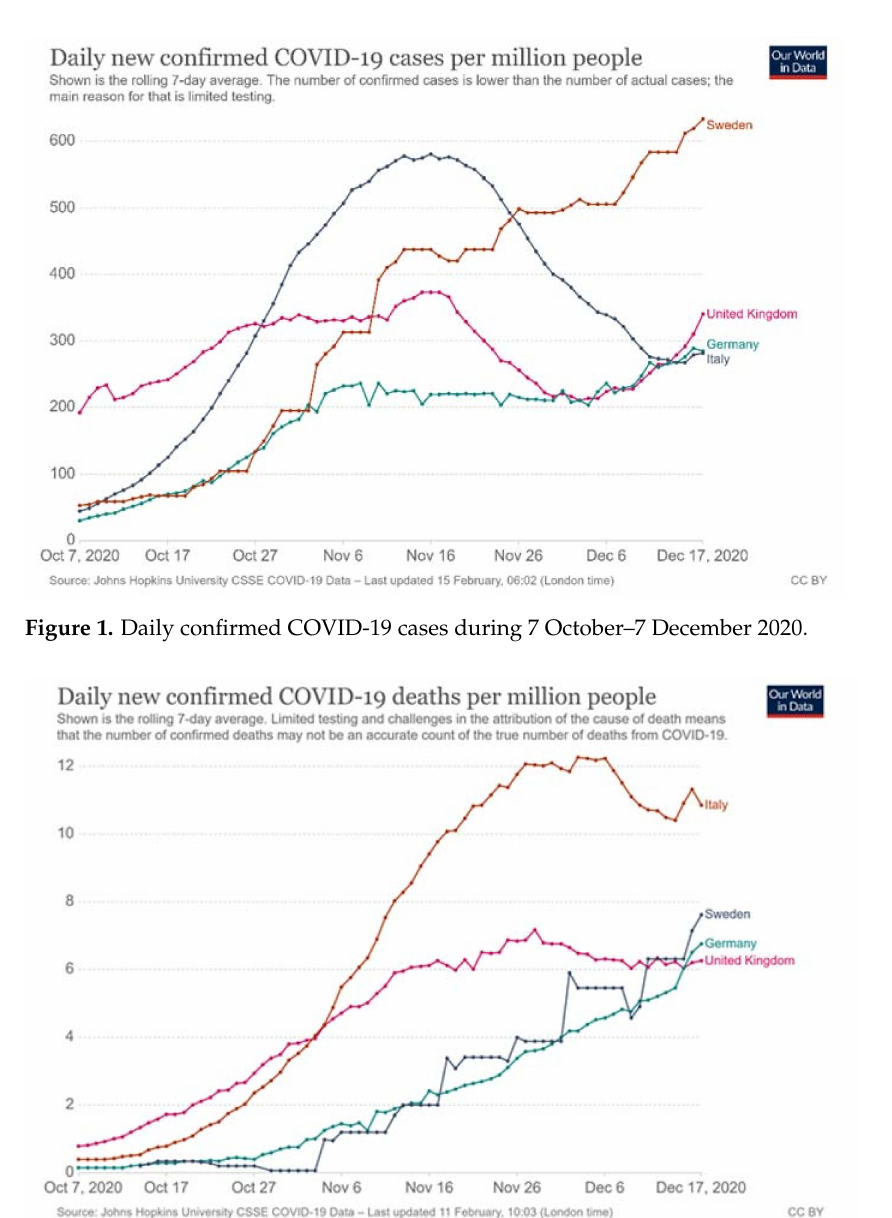
Figure 2. Daily confirmed COVID-19-related deaths during 7 October–7 December